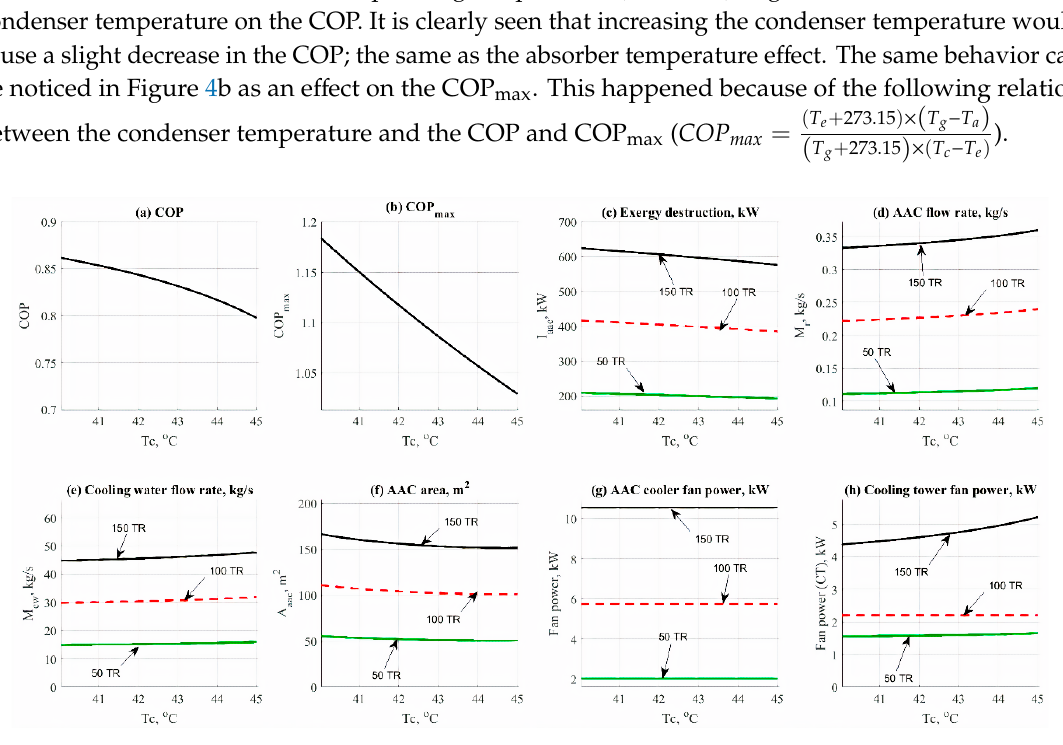
Figure 4. Data results based on the effect of condenser temperature parameter.